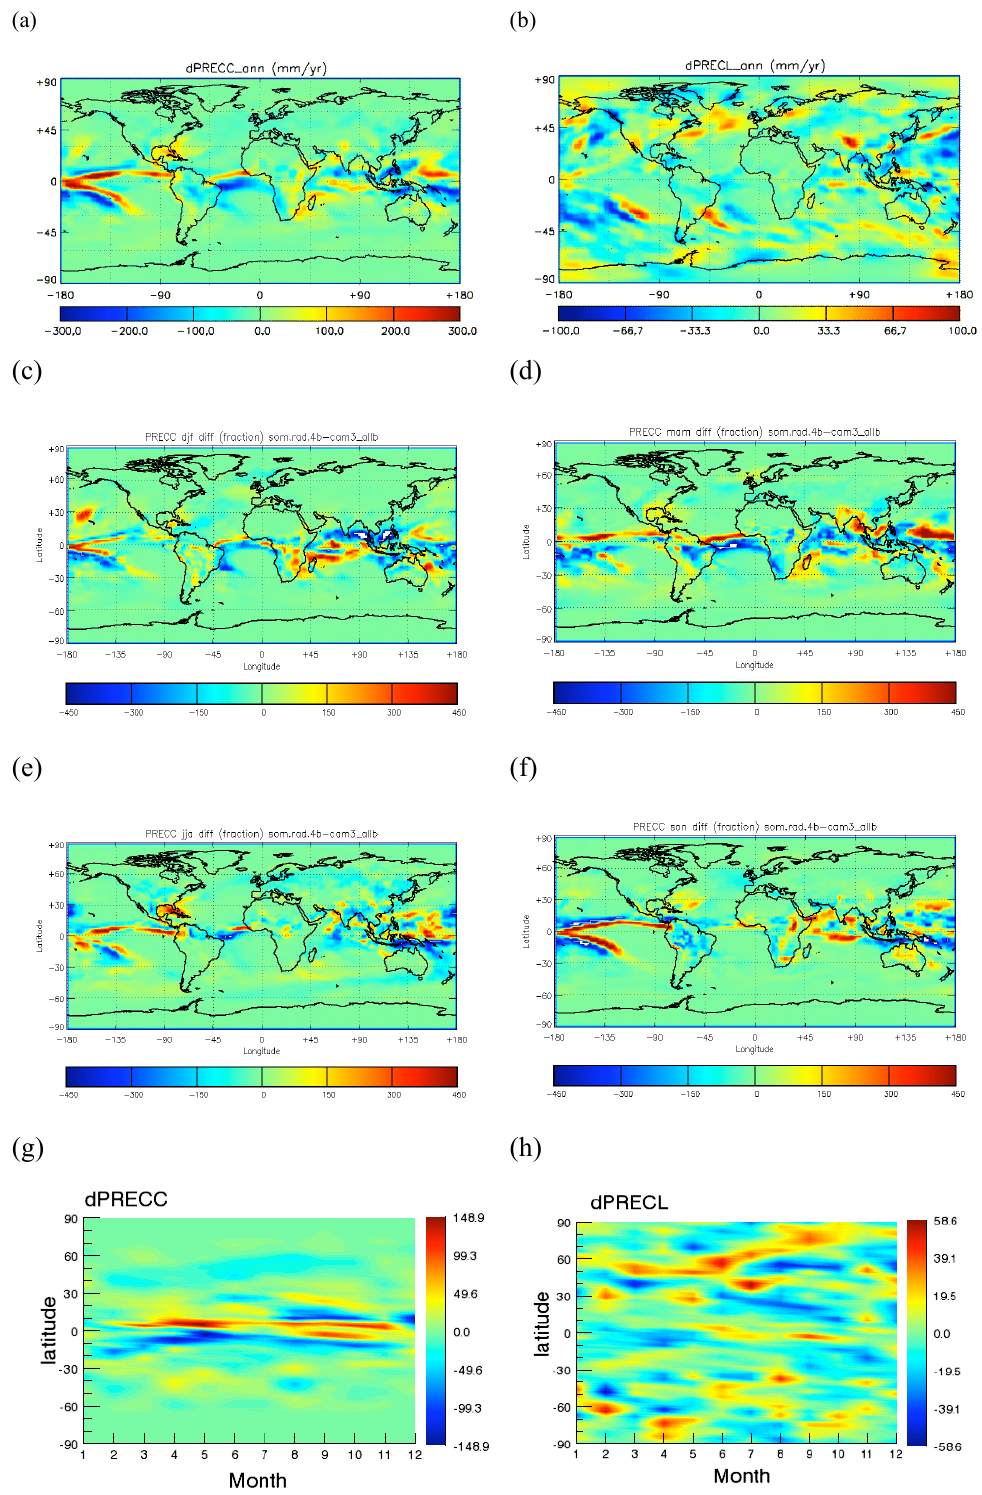
Fig. 12. Global distribution of annual mean of differences in precipitation due to seasonal BBCA emissions, (a) convective precipitation (PRECC) and (b) large scale precipitation (PRECL). Global distribution of seasonal means of differences in convective precipitation due to seasonal BBCA emissions in: (c) DJF, (d) MAM, (e) JJA, and (f) SON. Also shown are Hovm¨oller diagrams of zonal monthly means of differences in precipitation, (g) PRECC and (h) PRECL, due to seasonal BBCA